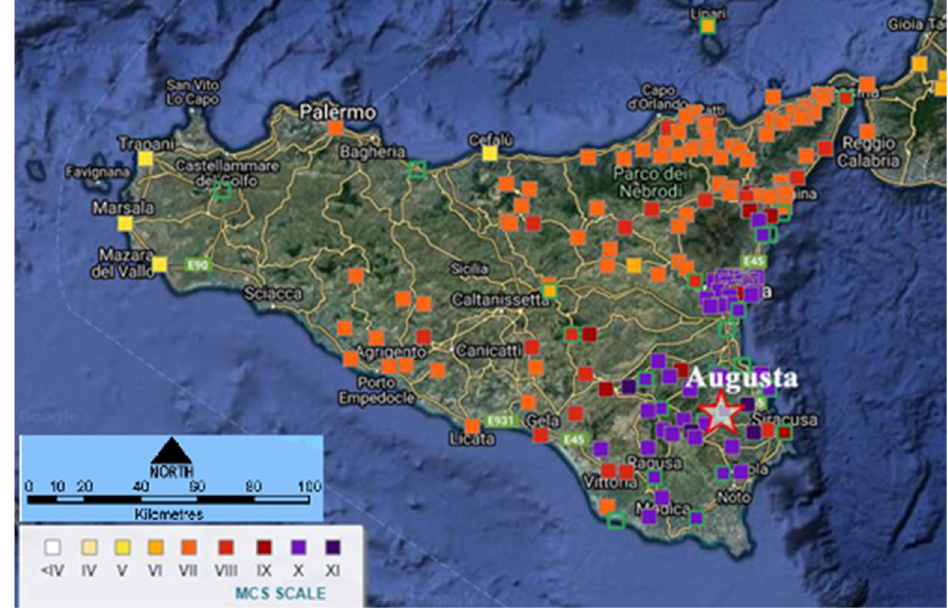
Figure 3. Intensity map. Earthquake of 11 January, 1693 (After Guidoboni et al. [24,25], modified, INGV database).